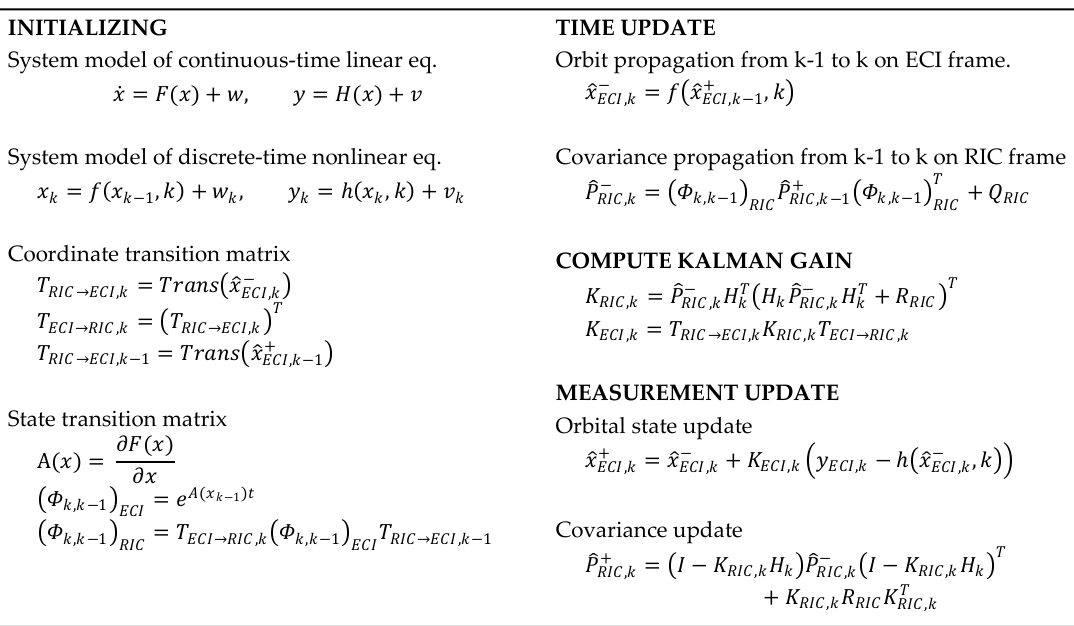
Table 2. Performance analysis results of on-board orbit determination with respect to reference orbit Table 1. Design of covariance of measurement noise according to the orbital